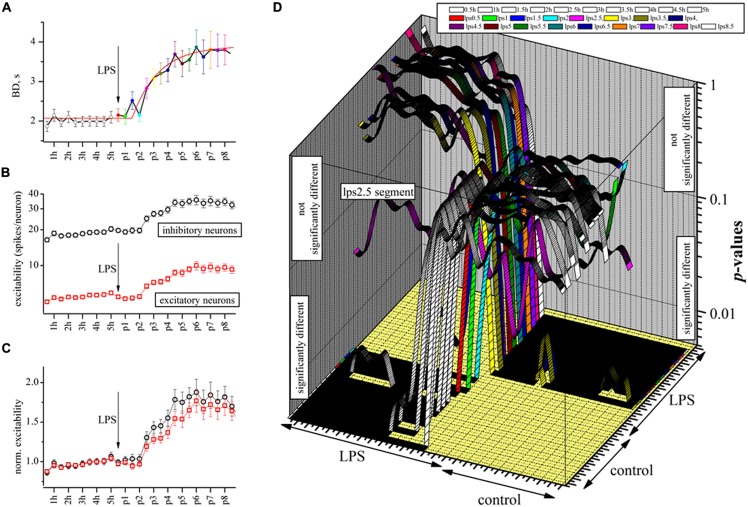
The delayed excitatory action of LPS studied at a half-hour resolution by analyzing BD and engaged excitatory and inhibitory neuron excitability. (A) Plot of BD in an exemplary experiment where time was divided into half-hour segments (10 in control and 16 during LPS). The red line is the best fit to an exponential function of the following type: fit line = 2.07 + 1.9*[1 - exp[-(x - τd)/τLPS]], where τd and τLPS are in seconds and represent the delay (5250 ± 970 s, n = 13) and the LPS onset time constant (8355 ± 2980 s, n = 13) which characterized the drug action, respectively. (B) For the same experiment, plot of excitability, defined as the average number of spikes elicited by engaged neurons in the same cluster in each up-state (red and black for excitatory and inhibitory cells). (C) For the same experiment, the data shown in (C) but normalized to the mean control data for each cluster (black and red symbols for inhibitory and excitatory neurons, respectively). Note the slow time course of excitability increase was similar in both neuron types. (D) 3D graph where each ribbon is the P-value of significance plotted vs. 27 time segments in the exemplary experiment of (A–C). There are 27 such ribbons plotted in order to evaluate all of the 702 (but those significant were 351) multiple pairwise (those identical were omitted) comparisons to compute the statistical significance by the non-parametric Kruskal–Wallis test (Dunn analysis, Bonferroni correction). Each ribbon is for each 0.5 h segment (open ribbon for control, colored ribbons for LPS data). Control (before) and LPS regions (succeeding) are indicated. Since the vertical axis of the P-values is in the form of a log-scale whose middle point is 0.05, all the regions where ribbons are above or below 0.05 represent non significant or significant comparisons, respectively. The time segment “lps2.5” that is in between control and steady-state LPS segments resulted in a “strange” shape. The data show that during control and well after LPS application, the BD data are significantly similar; however, during the development of the LPS action, they slowly (after each half hour) changed consistently to the differences shown in Figures 3A–C.